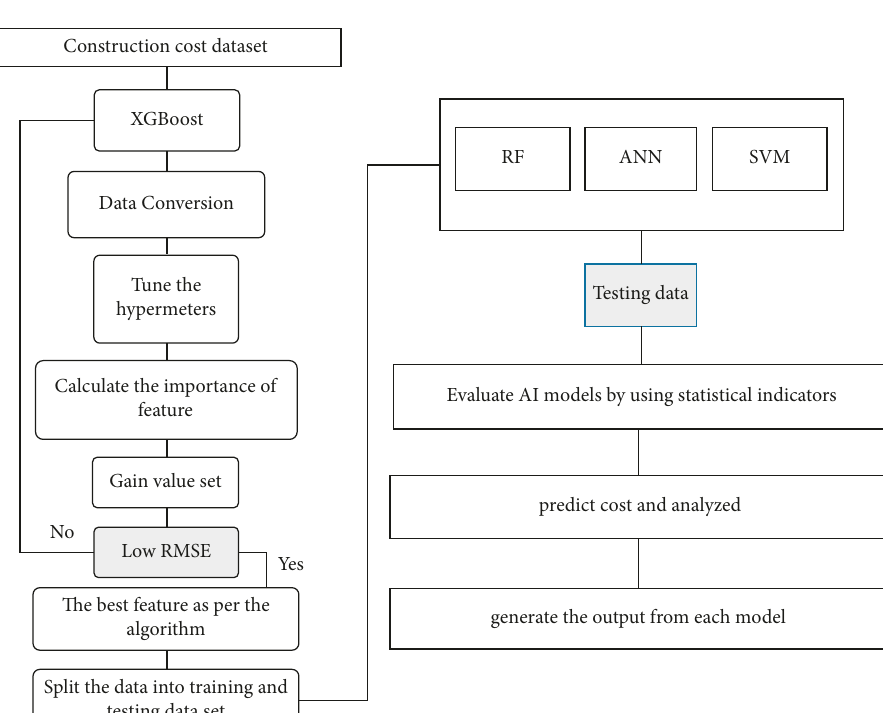
Figure 4: The proposed AI model for construction cost estimation.